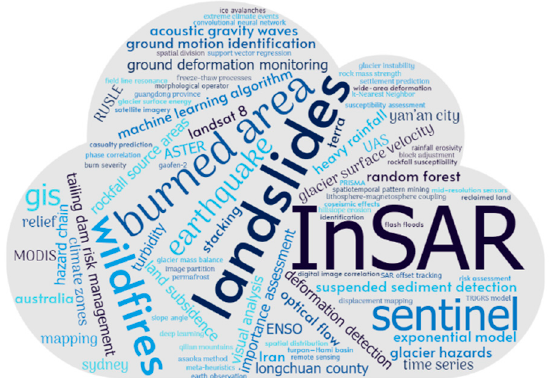
Figure 3. Word clouds (also known as text clouds or tag clouds) generated from the keywords of all contributions to the present Special Issue. The more a word appears as a keyword, the bigger and bolder it appears in the word